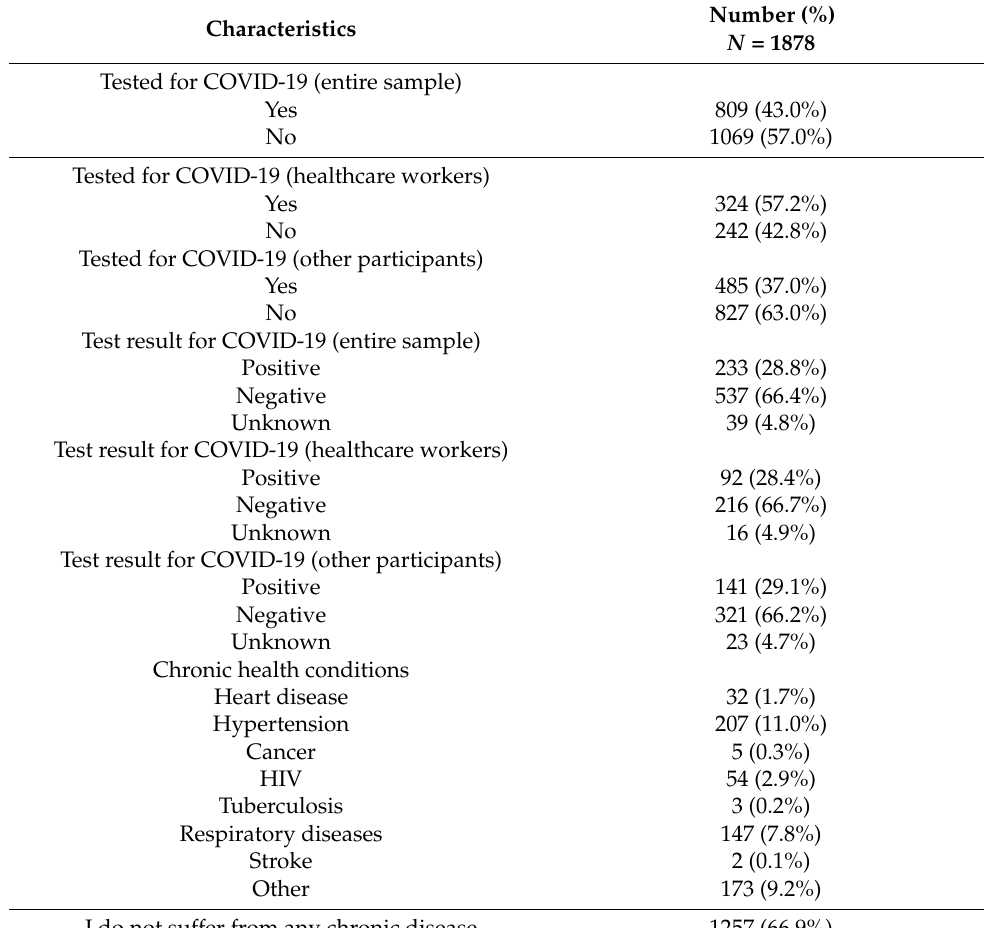
Table 2. Participants’ health